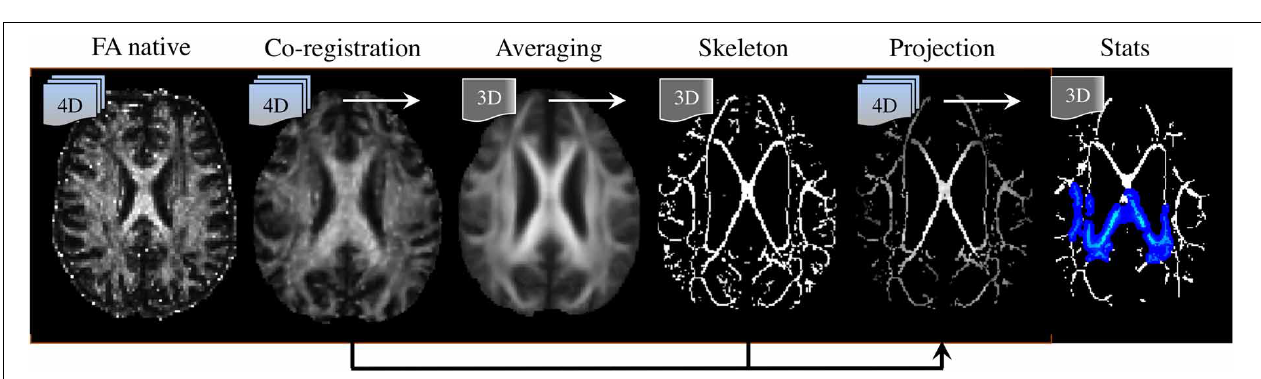
FIGURE 8 | Tract-based spatial statistics (TBSS) processing pipeline. (Left to right) DTI-derived fractional anisotropy (FA) images are co-registered to